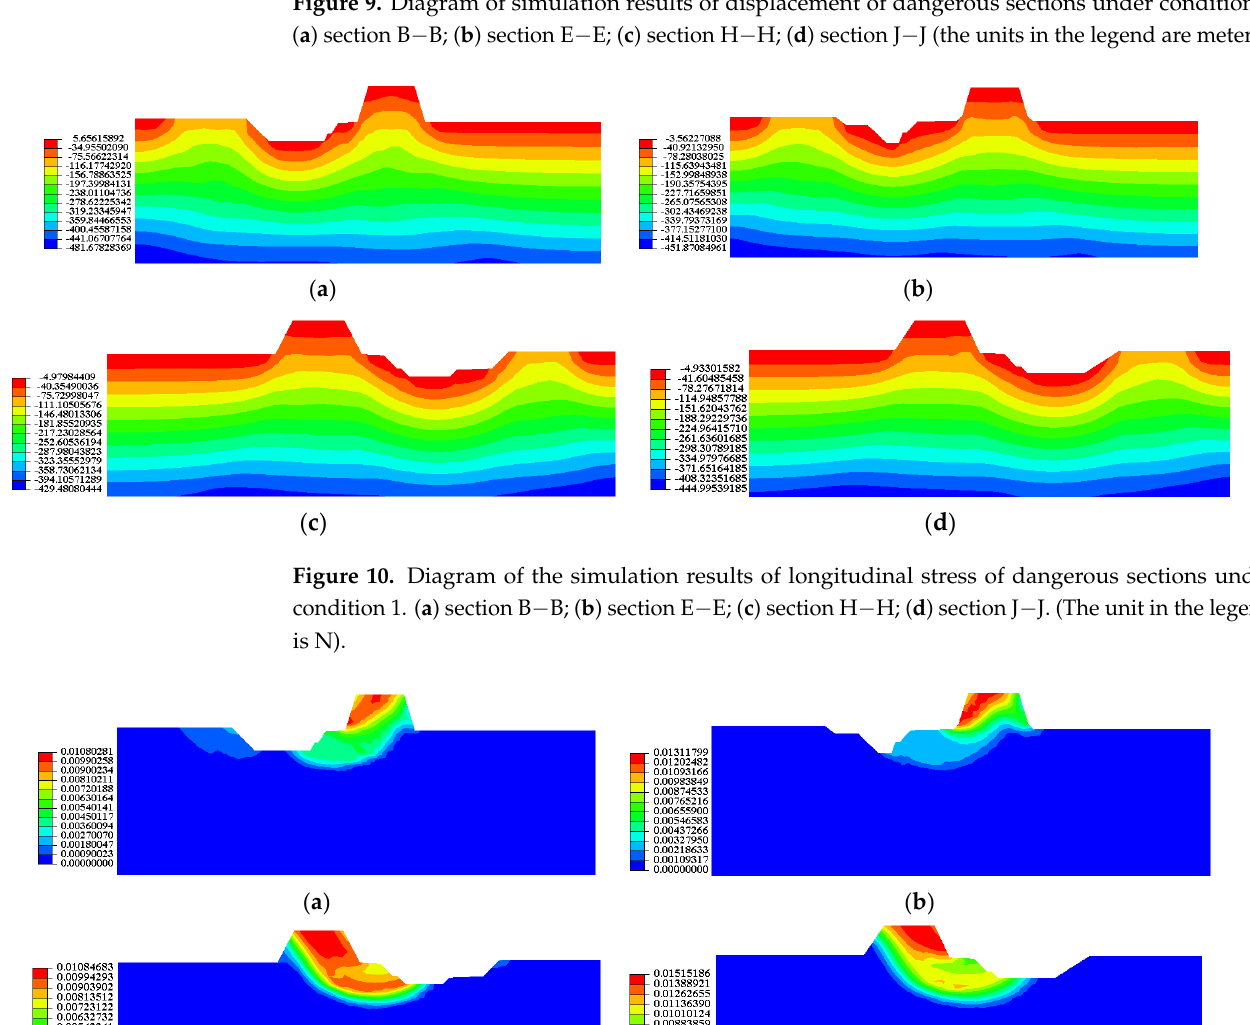
Figure 9. Diagram of simulation results of displacement of dangerous sections under condition 1.